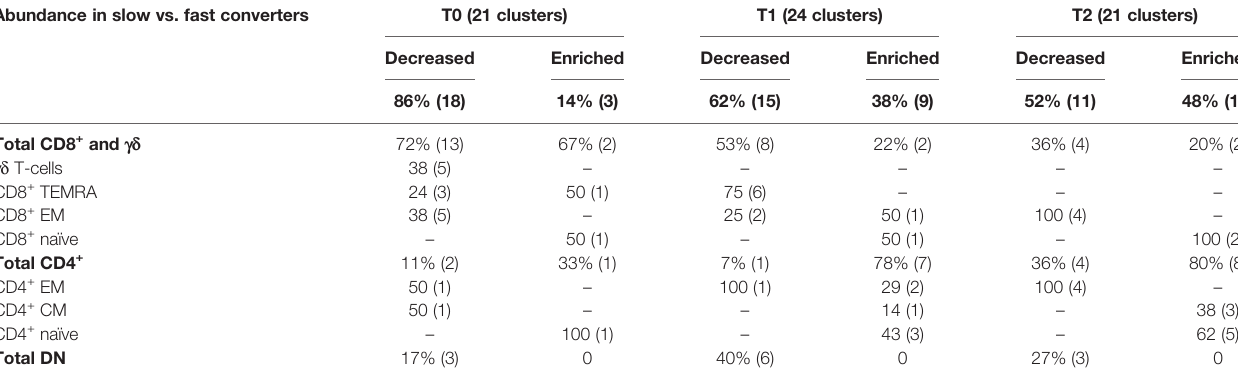
TABLE 2 | Proportions of the main T-cell subpopulations within enriched or decreased subsets in slow converters compared to fast converters. Abundance in slow vs. fast converters